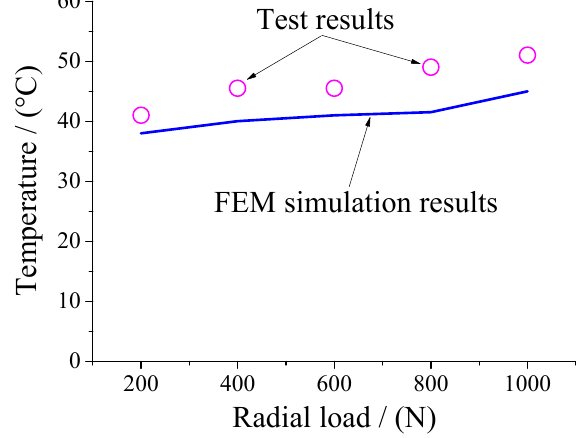
Figure 16. Comparison between the tested and FEM simulation values of temperature under different radial loads (inner ring speed: 1800 r/min, kinematic viscosity: 15